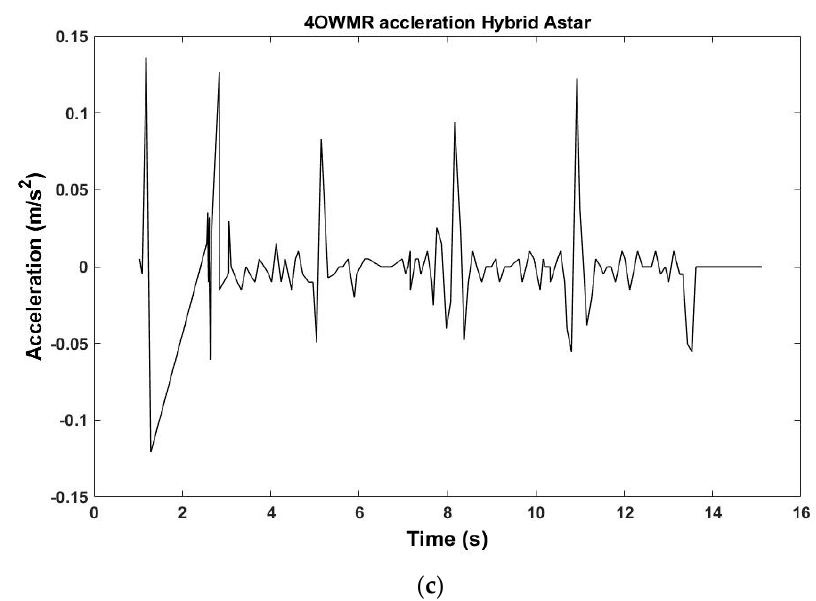
Figure 6. ( a ) The velocity reading of each wheel of the 4OWMR during Hybrid A* implementation for Map1. ( b ) The velocity of the 4OWMR during Hybrid A* implementation for Map1. ( c ) The acceleration of the 4OWMR during Hybrid A* implementation for Map1.